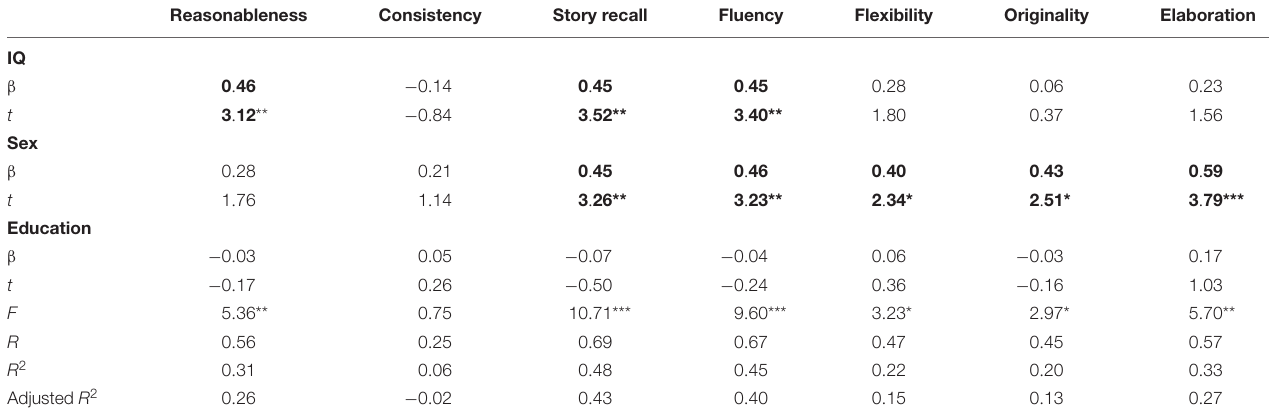
TABLE 5 | Multiple regression for problem solving